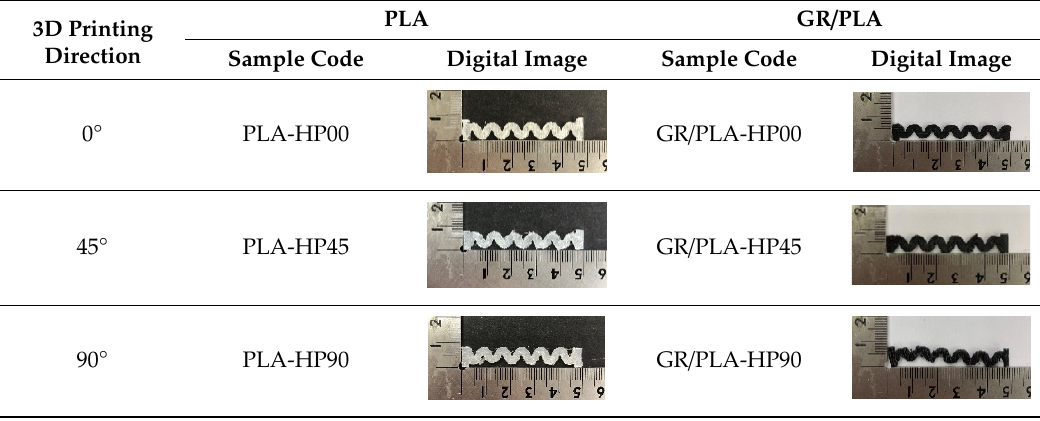
Table 2. Sample codes of CFDM 3D-printed horseshoe pattern with various 3D printing conditions.